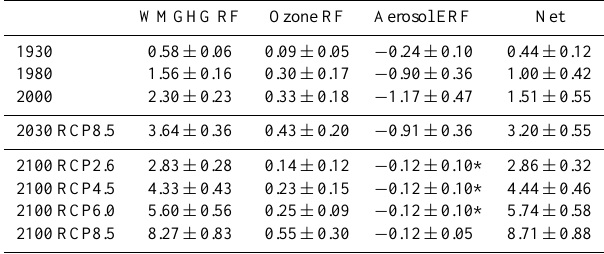
Table 8. Global mean annual average anthropogenic composition forcings and